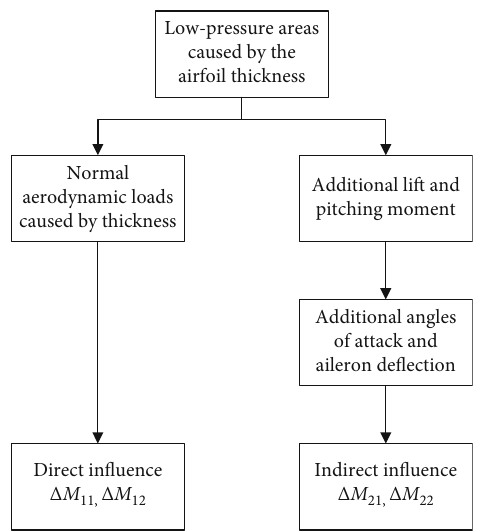
Figure 16: Two ways in which the low-pressure areas a ff ect the hinge inner wing and fuselage. The pressure nephogram (Figure 15) of 90 ° folding angle con fi guration calculated by